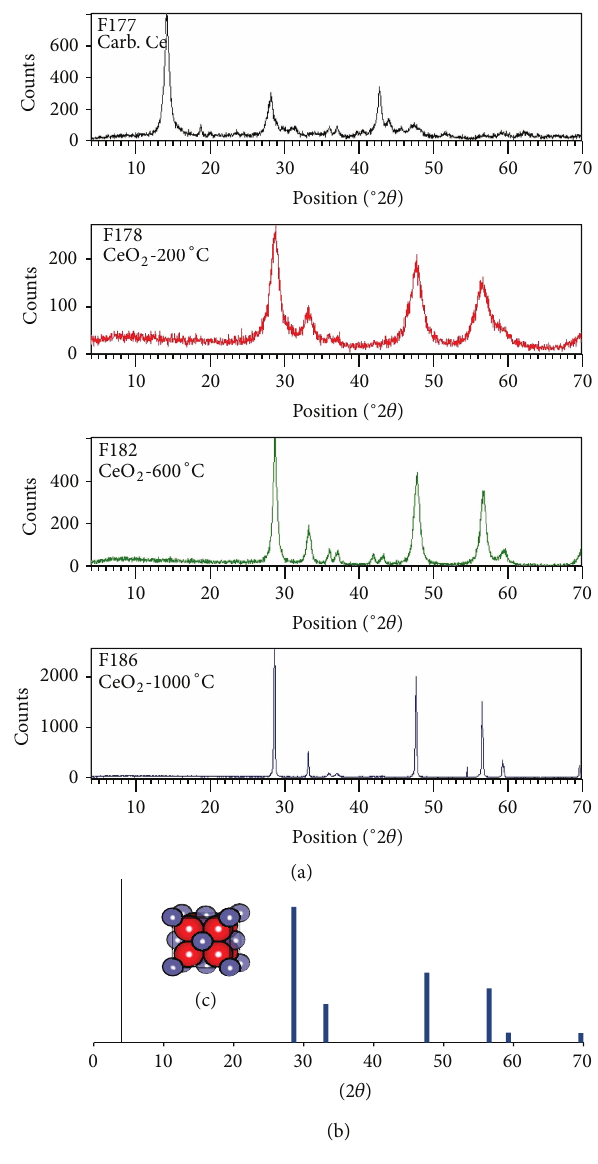
Figure 2: (a) XRD patterns of cerium carbonate (precursor) and cerium oxides annealed at 200, 600, and 1000 ∘ C (from top to bottom). (b) Peak positions and relative intensities calculated from structure parameters using VESTA 3 SW [21], input data from PDF 81-0792. (c) Fluorite-like cubic structure of CeO 2 .